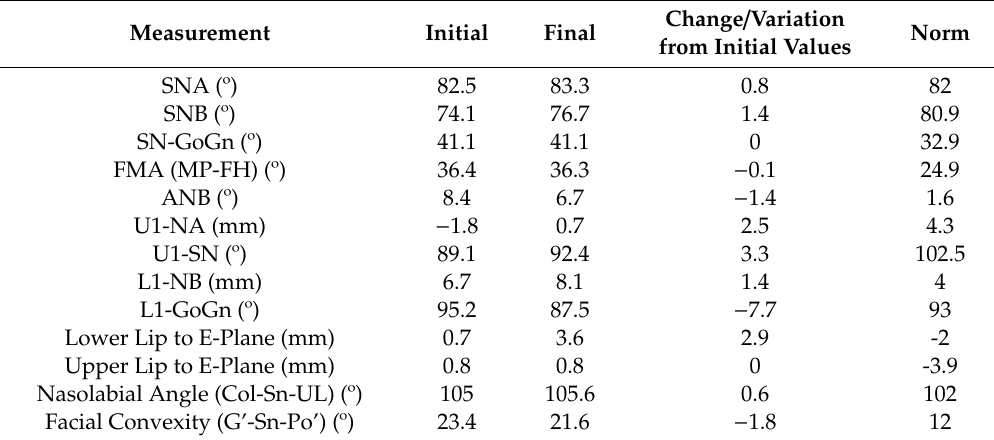
Table 3. Before-and-after treatment cephalometric analyses of Case